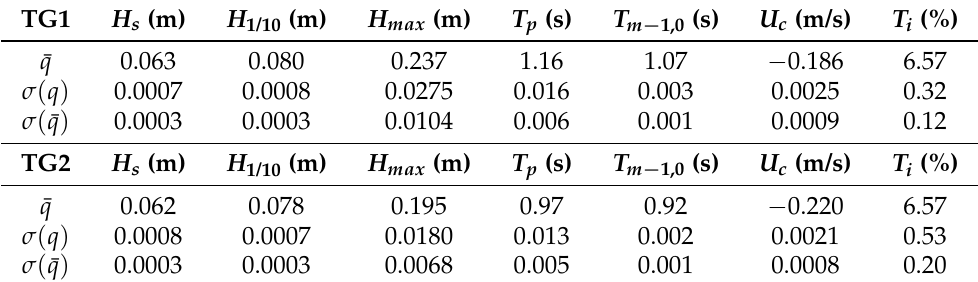
Table 5. Repeatability of measured wave and current